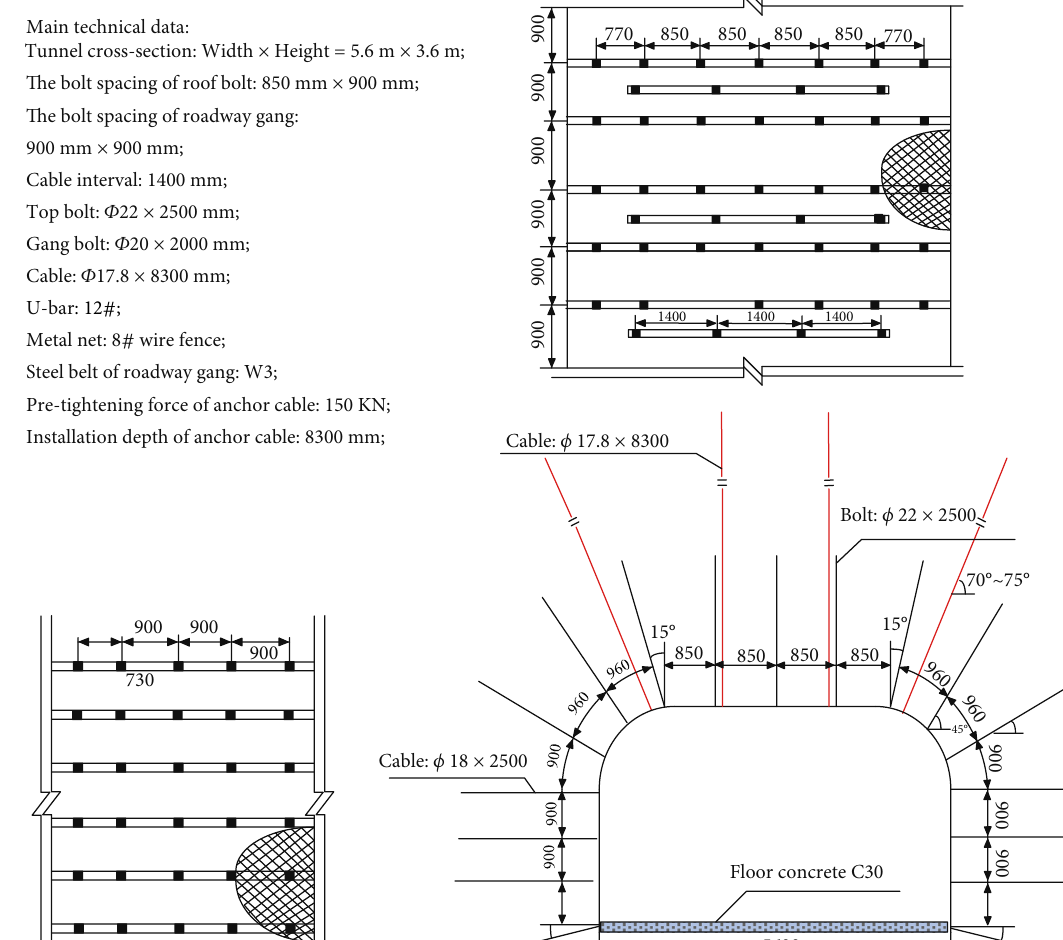
Figure 15: The new support parameter of the soft-rock coal roadway.